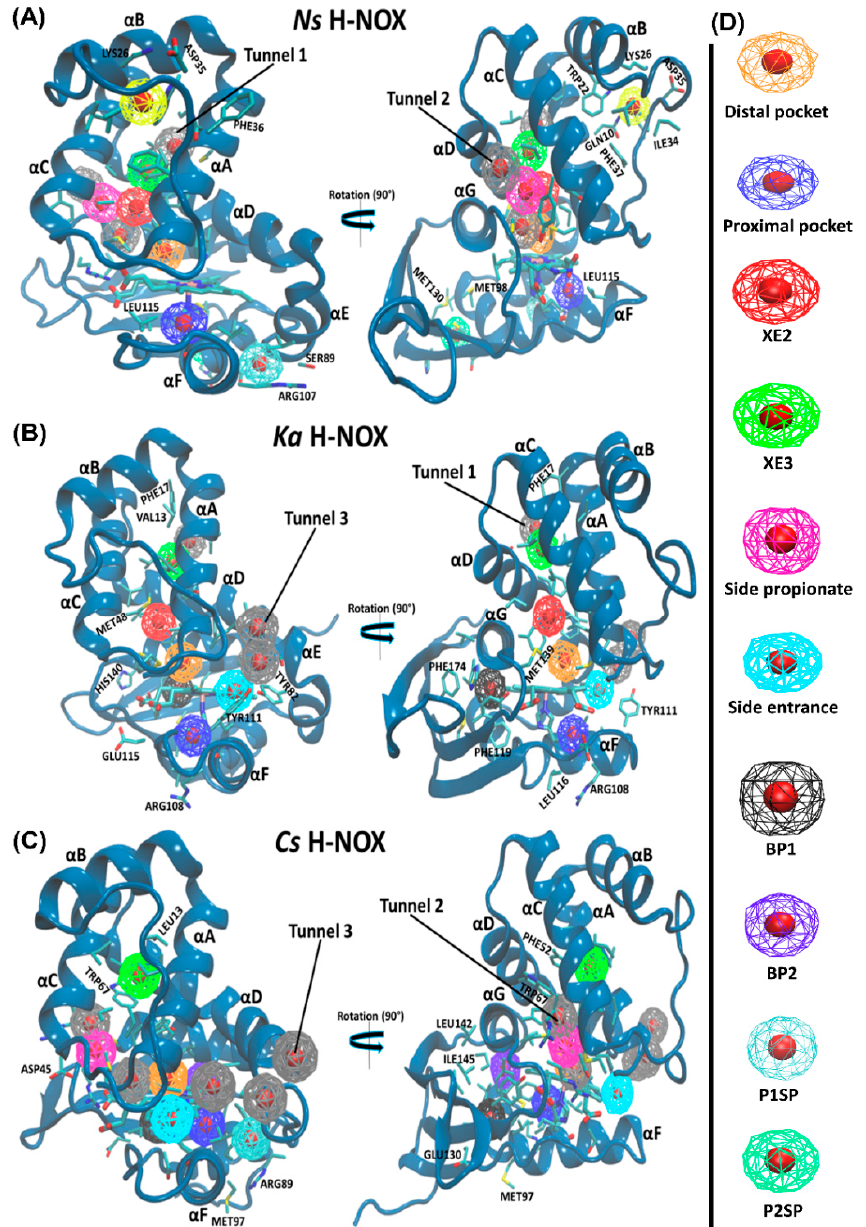
Figure 5. Gas-binding cavities in the studied H-NOX systems. Color coding used for the cavities are shown in the panel on the right.